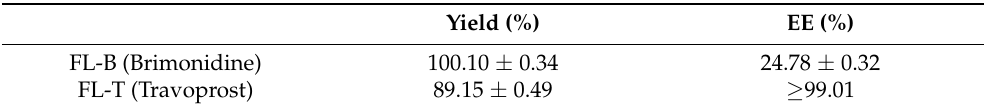
Table 3. Quantification and encapsulation efficiency of the active ingredients brimonidine and travoprost in liposomal formulations, determined by